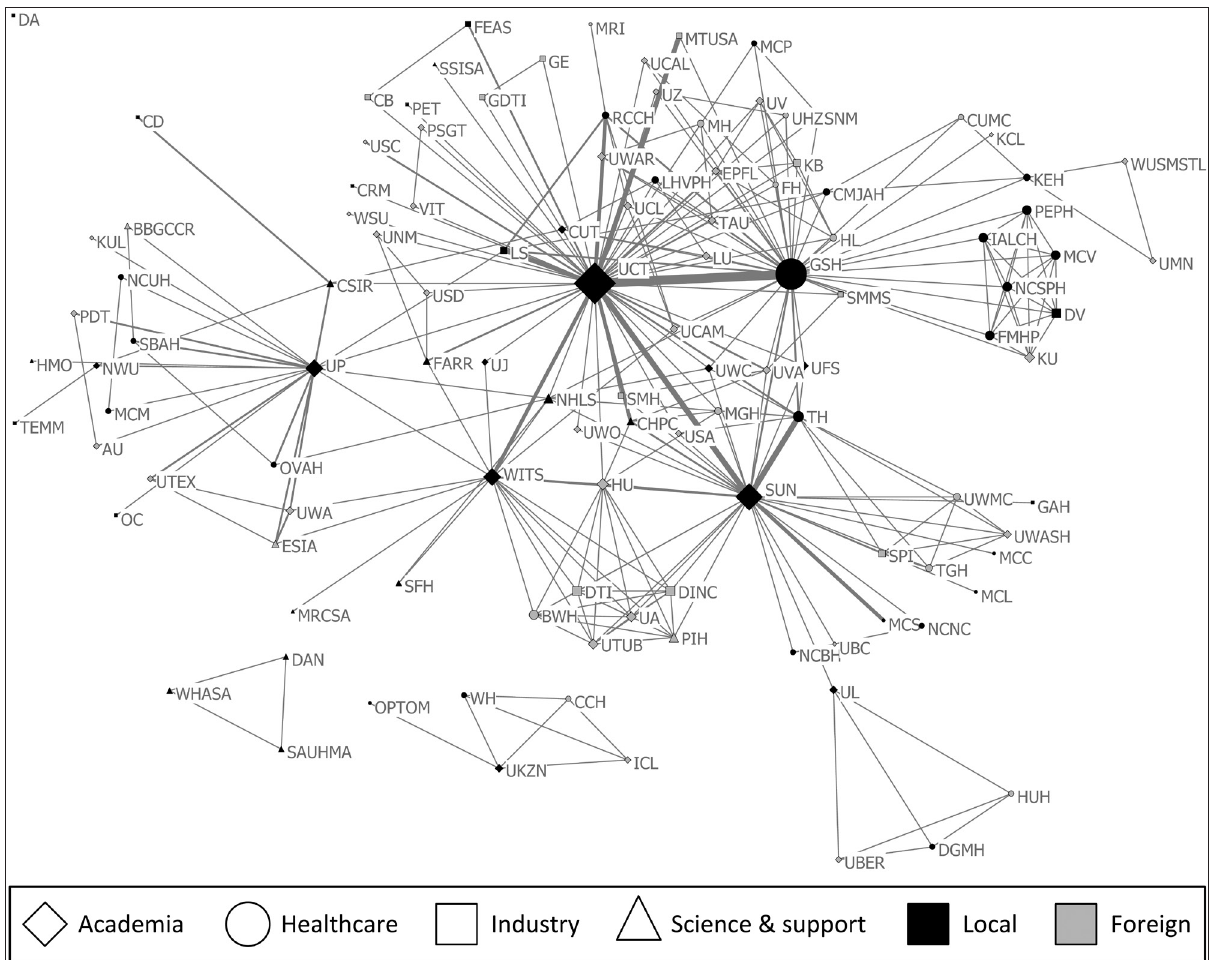
Figure 1: Collaboration network of institutions generated using all relevant publications found during the period 2000–2013. Node size scaled according to node degree. Edge thickness weighted according to number of publications co-authored. Institution names and abbreviations are listed in Supplementary tables Table 2: Ten highest ranking nodes for the normalised centrality measures: degree, closeness and betweenness Degree centrality Closeness a centrality Betweenness centrality Rank Institution Sector Value Institution Sector Value Institution